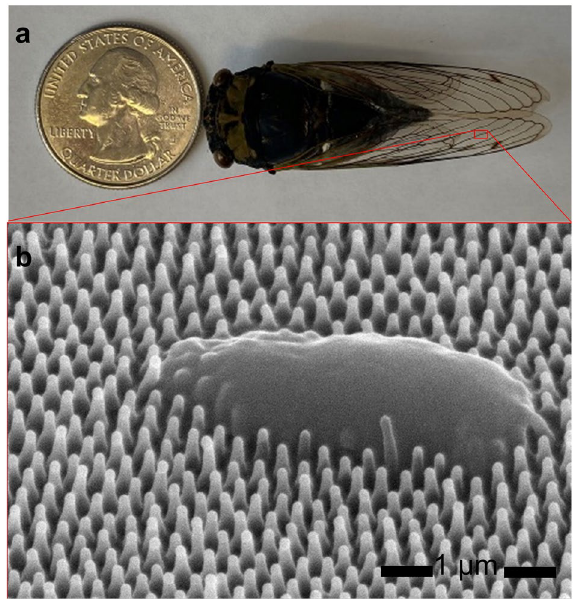
Figure 1. (a) Image of an annual cicada ( Neotibicen canicularis ) compared to a US quarter. ( b ) SEM image of the nanostructures on the wing surface of the cicada with E. coli on the wing